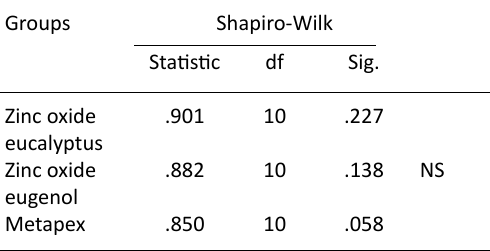
Table 2. Normality test of C. albicans